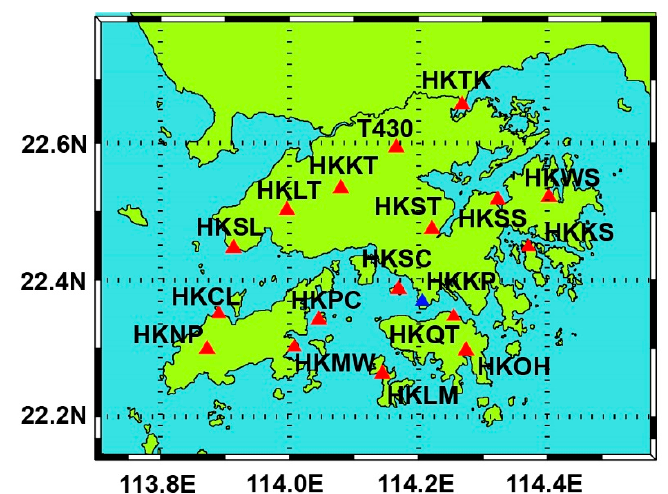
Figure 5. Horizontal distribution of the SatRef and meteorological station